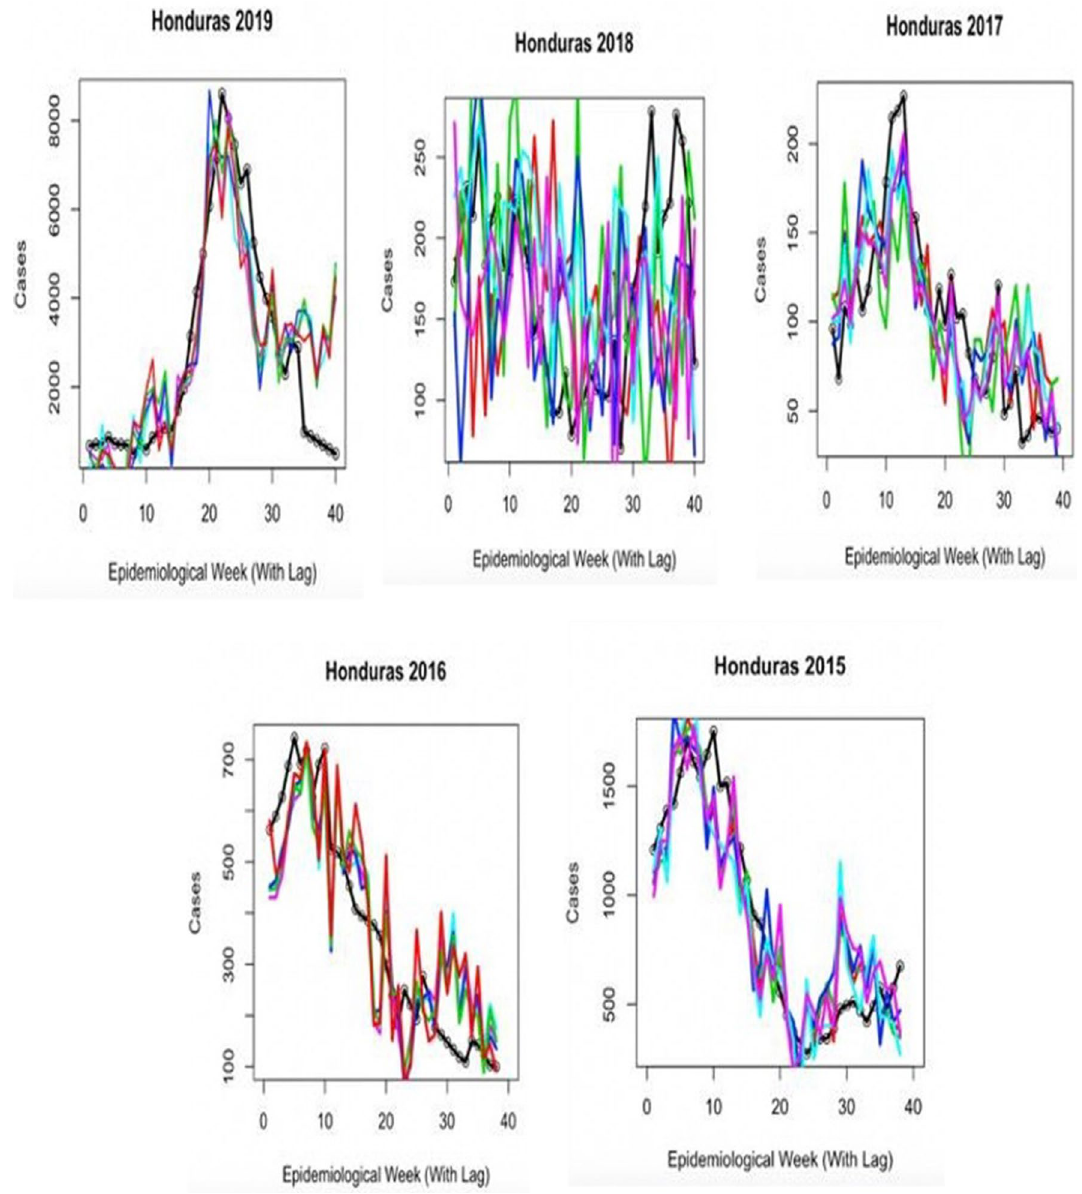
Figure 7. Graph showing the results of climate model testing (with lag) of climate model testing for Honduras model from 2015 to 2019. Colored lines represent five different forward simulation runs. Solid black line is the reported case count for each